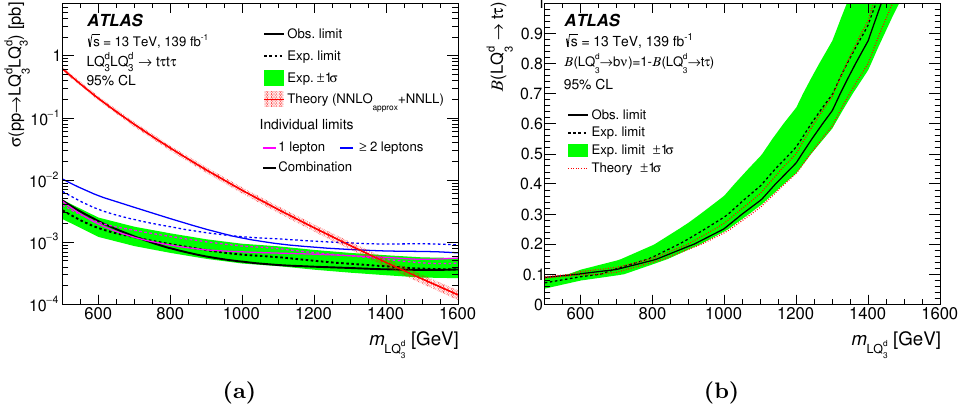
Figure 15. (a) Observed (solid line) and expected (dashed line) 95% CL upper limits on the LQ d pair production cross section as a function of m resulting from the combination of all LQ d 3 3 analysis channels, assuming B = 1 . The surrounding shaded band corresponds to the ± 1 standard deviation ( ± 1 σ ) uncertainty around the combined expected limit, as estimated using the asymptotic approximation (see text). This approximation is found to overestimate the +1 σ ( − 1 σ ) uncertainty of the combined expected limit by about 5%–15% (15%–30%), depending on m . The red line LQ d 3 and band show the theoretical prediction and its ± 1 σ uncertainty. The individual expected limits for the 1 ‘ + ≥ 1 τ channel and the combination of the 2 ‘ OS+ ≥ 1 τ and 2 ‘ SS/ 3 ‘ + ≥ 1 τ channels are shown as the magenta and blue dashed lines, respectively. (b) Observed (solid line) and expected (dashed line) 95% CL upper limits on B as a function of m resulting from the combination of LQ d 3 all analysis channels. The surrounding shaded band corresponds to the ± 1 σ uncertainty around the combined expected limit. The same statement regarding the asymptotic approximation given for (a) applies. The dotted red line around the observed limit indicates how the observed limit changes when varying the theoretical prediction for the LQ d pair production cross section by its 3 ± 1 σ